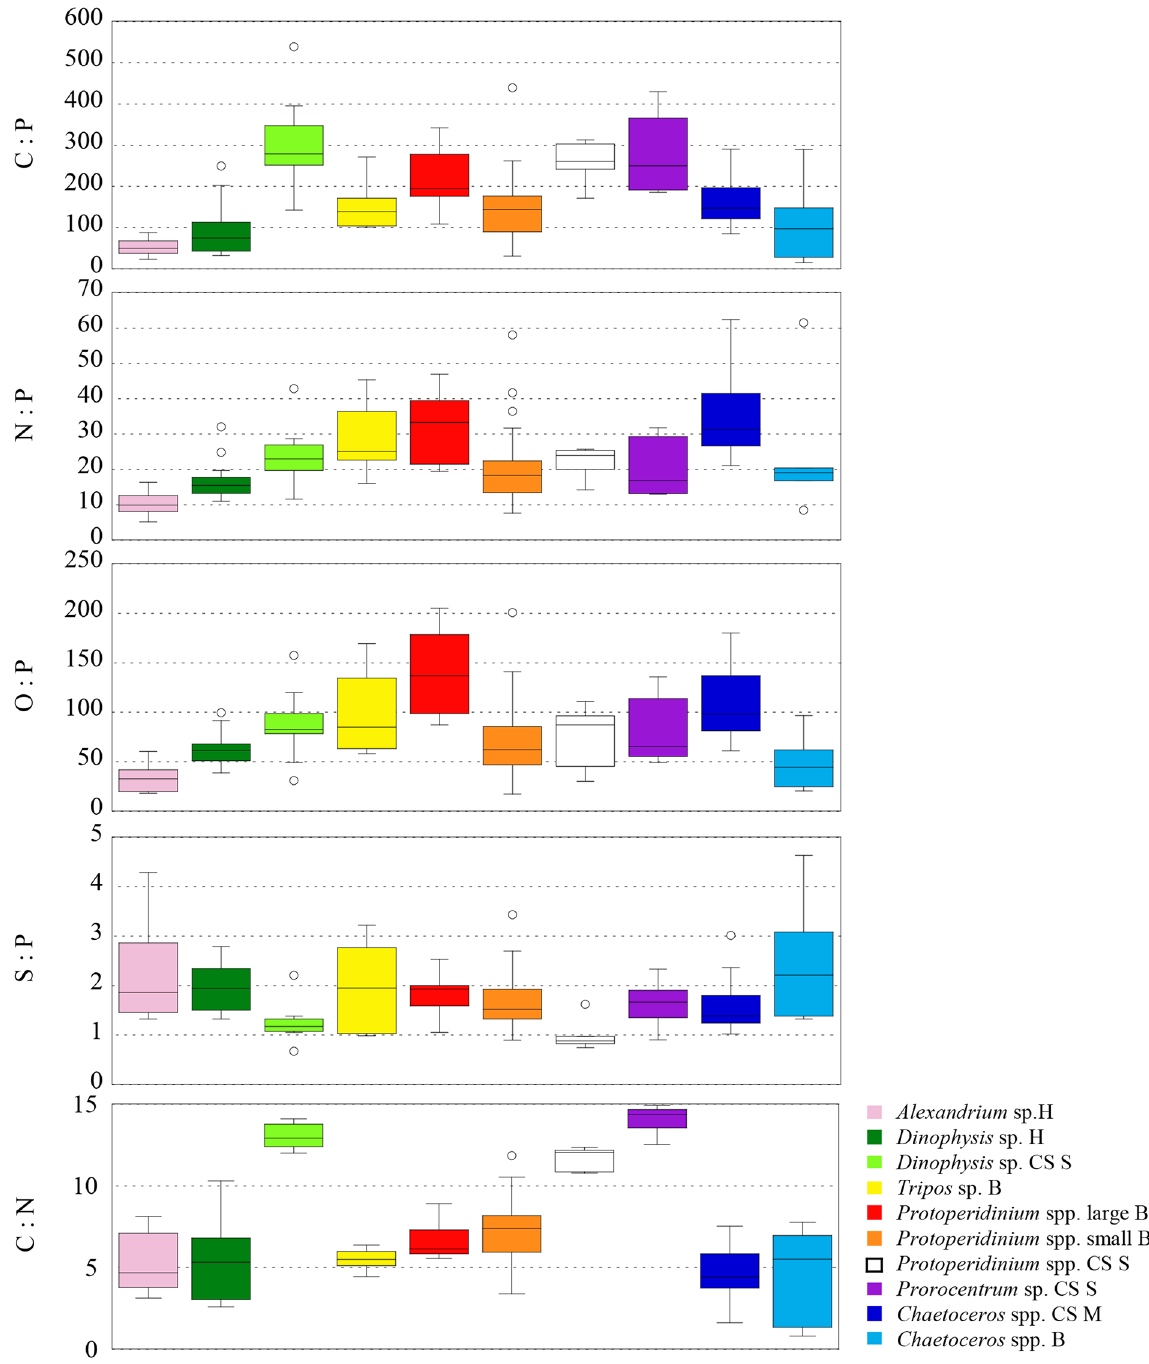
Fig 7. Box plots comparing different molar ratios (C:P, N:P, O:P, S:P, and C:N) of dinoflagellates and diatoms from the NW Mediterranean Sea. H: Harbour; B: Bay; CS S: Continental Shelf Stratified water column; CS M: Continental Shelf Mixed water column.